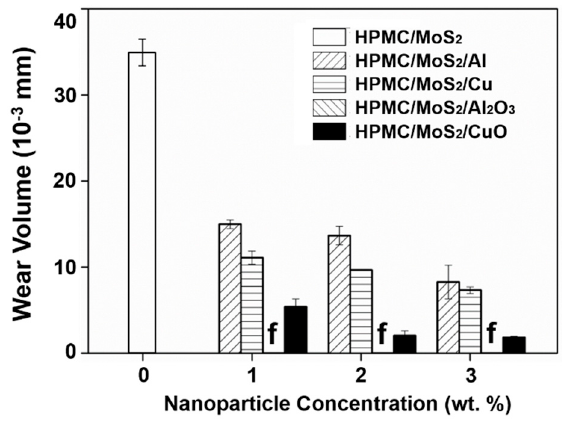
Figure 7. Wear volume of the HPMC / MoS 2 / additive composites (sliding distance 100 m). f represents the failure of the coating.